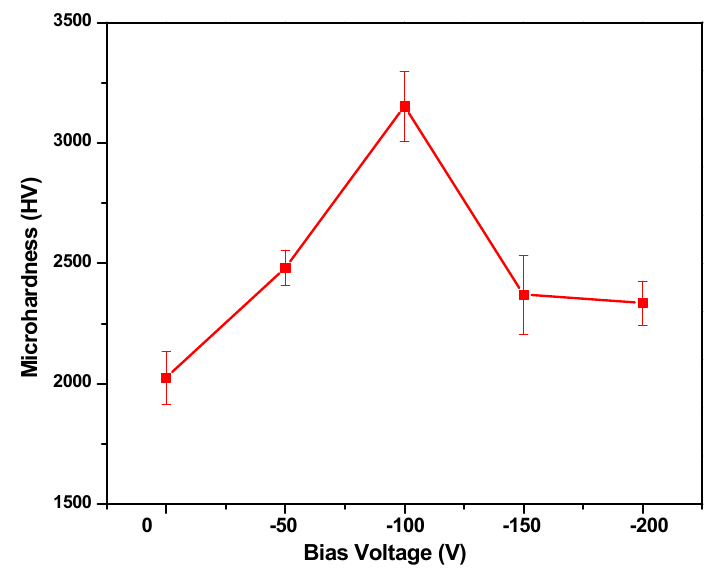
Figure 7. Micro-hardness values of Cr–Si–N coatings deposited under different bias voltages.